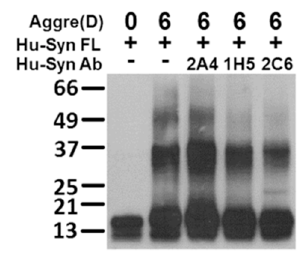
Figure 9. Interaction between antibodies and full-length Hu-syn obtained using Western blotting detection and probed with antibody 2A4. Monoclonal antibodies 2A4 and 2C6 could prevent the oligomeric formation of full-length Hu-syn.